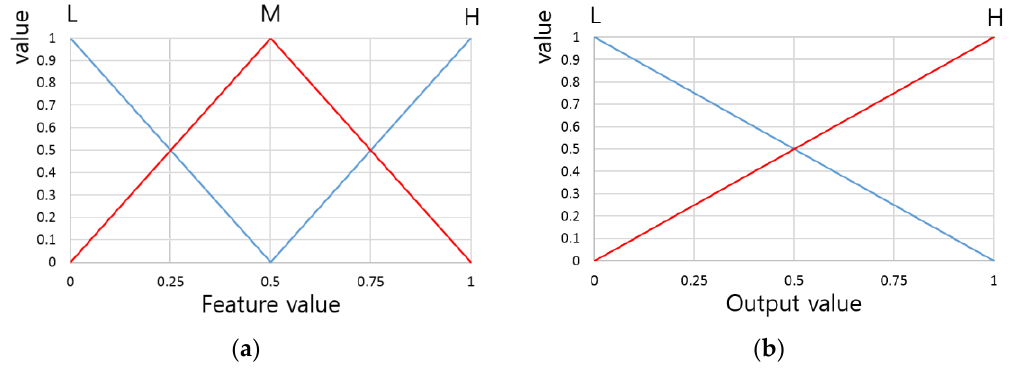
Figure 5. Banknote fitness classification system membership functions: ( a ) Input membership function; ( b ) Output membership function.